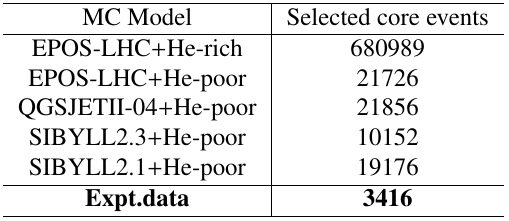
Figure 4. The comparison of some observable parameters ( N btop , R N b R , ) between experimental data and MC simula- (cid:31) (cid:30) (cid:31) (cid:30) tion which are calculated for various combination of interaction and composition models. Table 2. The average purity and e ffi ciency of the selected events by T c ≤